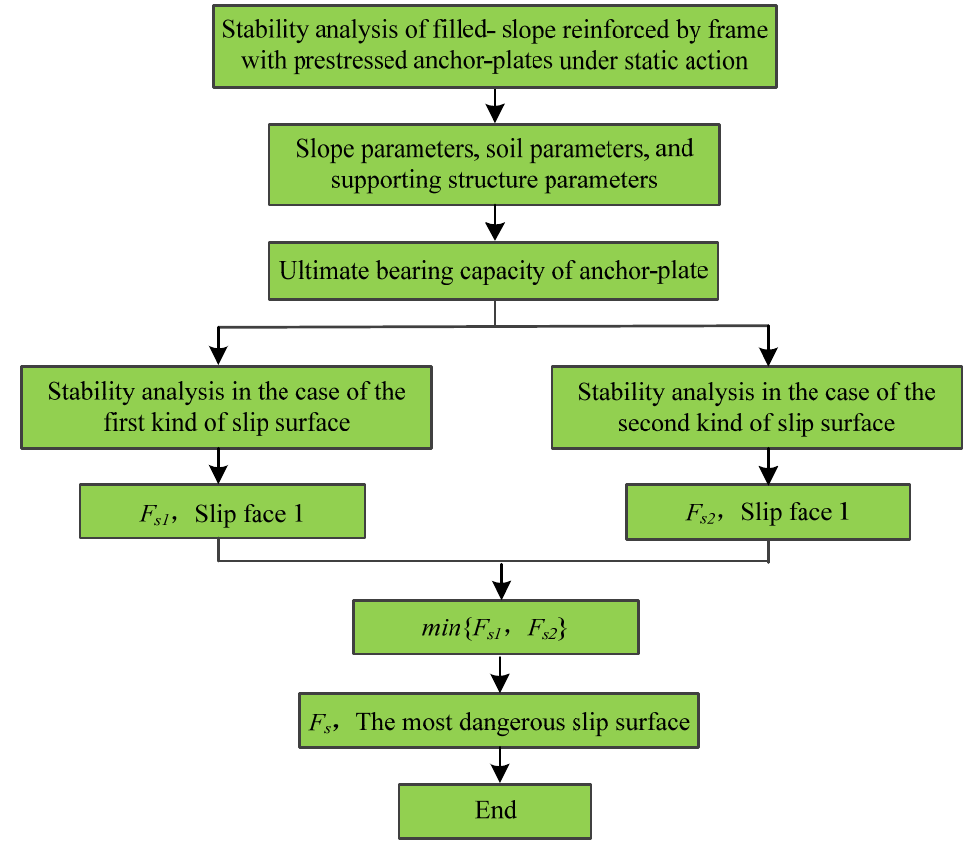
Figure 17. Flow chart of stability analysis.